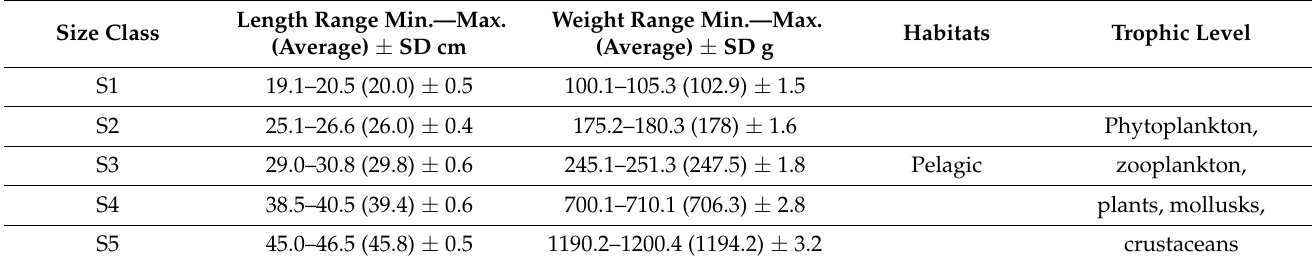
Table 1. Length-weight based size classes, habitat, and trophic level of T. ilisha for the purposes of this study. Length Range Size Class